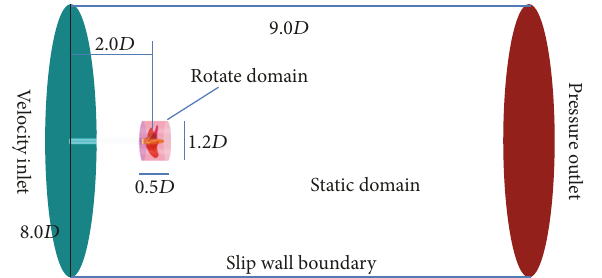
Figure 15: Computational domain for propeller simulations in open water.